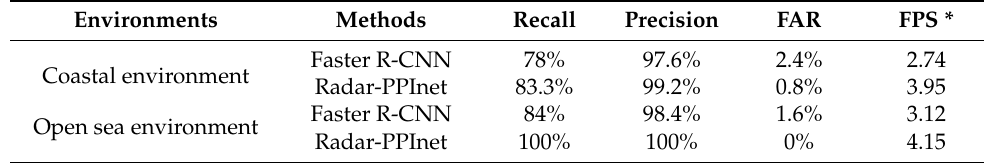
Table 3. Detection performance in different environments using Faster R-CNN and Radar-PPInet.